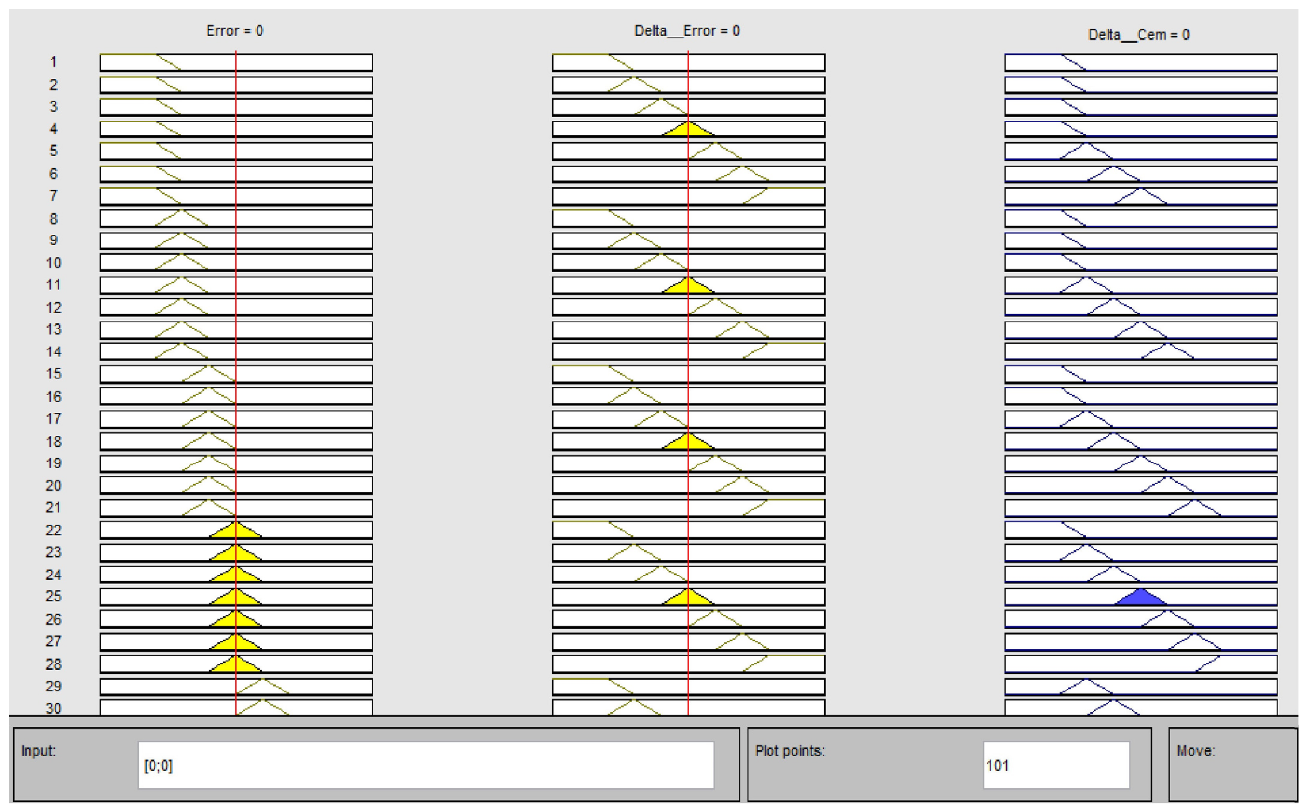
Figure A7. Rule. Figure A7.